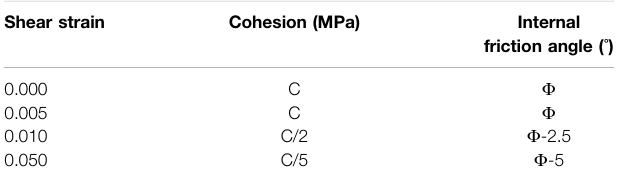
TABLE 3 | Estimated stress and strain of goaf materials according to Salamon ’ s theoretical